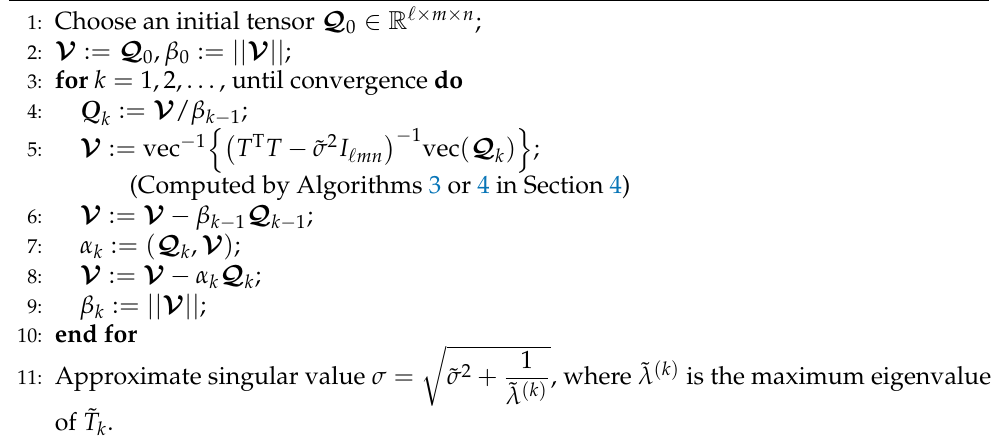
Algorithm 1: Shift-and-invert Lanczos method for an arbitrary singular value over tensor